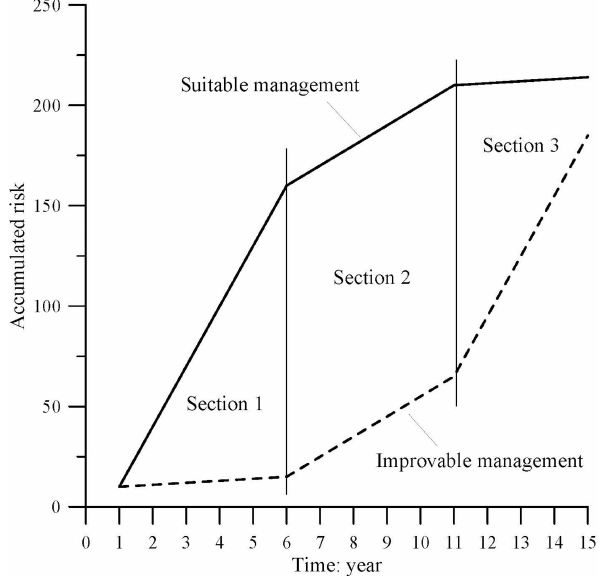
Figure 1. Theoretical evolution of risk accumulated over time for a 1-year series